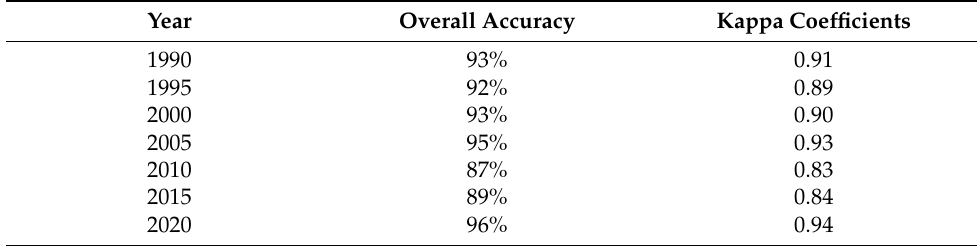
Table 3. The overall accuracy and kappa coefficients for the waterbody